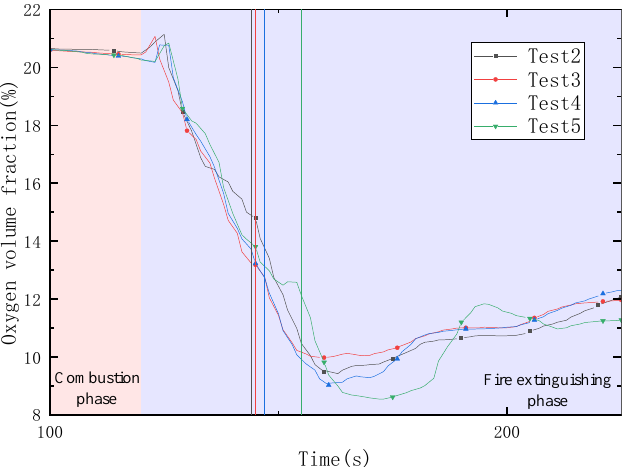
Figure 6. Oxygen volume fractions around the fire source under different flow rates.